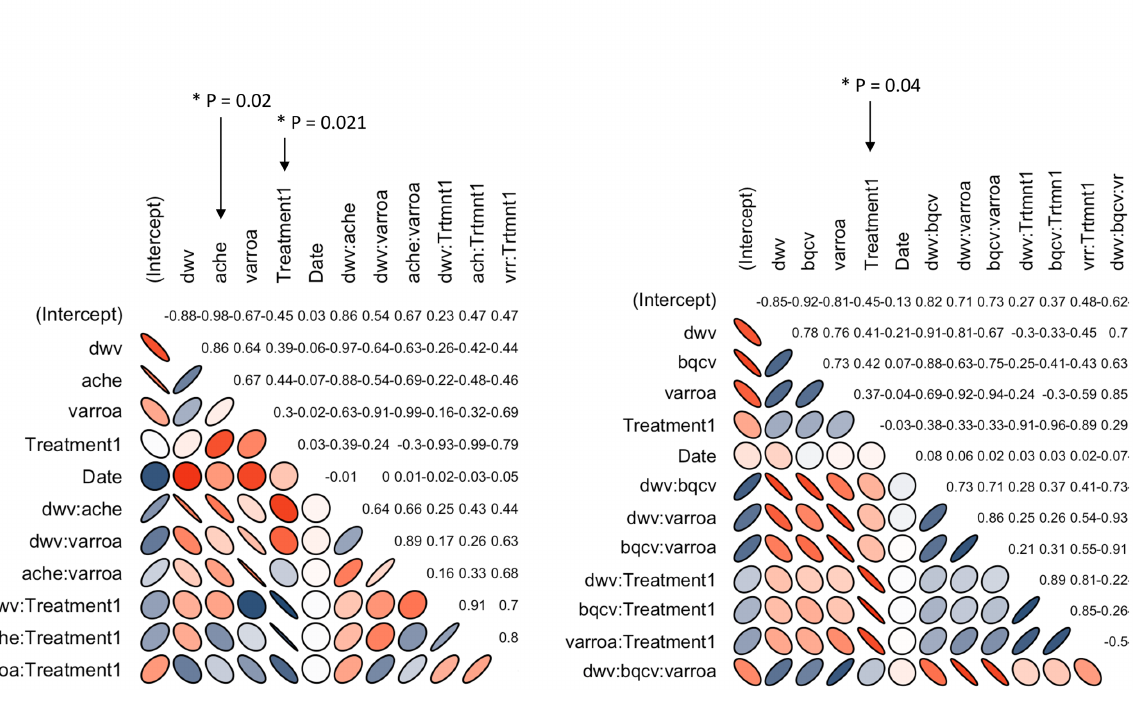
Fig 6. Overtime significant correlations between studied variables (AChE, DWV, BQCV and varroa) and the treatment factor. P values are * P < 0.05, r values are indicated for each pair of variable in the correlation matrixes and are calculated based on the linear mixed models of the fixed effect by allowing interaction between